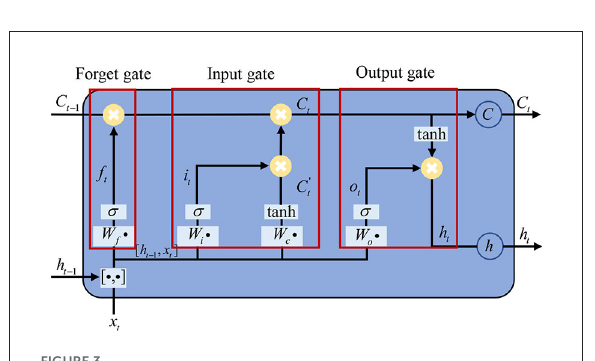
FIGURE3 Illustration of the LSTM network.